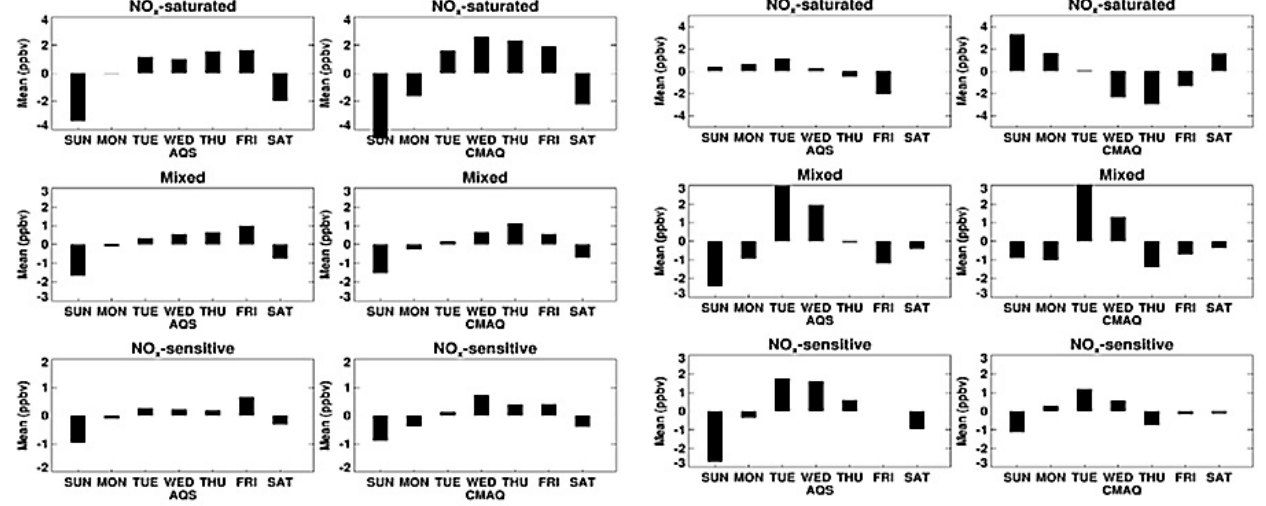
Fig. 8. Weekly anomalies of AQS-observed and CMAQ-simulated ground-level NO x at EPA AQS NO x stations (left two columns) and O 3 concentrations at EPA AQS O 3 stations (right two columns) over CMAQ-derived chemical regimes (i.e., NO x -saturated, mixed, and NO x - sensitive regimes, see the right panel of Fig. 3) for August 2009. Only daytime (01:00–05:00p.m., local time) NO x and O 3 concentrations are used; some data are filtered out from 17–19 August 2009, when Tropical Storm Ana strongly affected air quality over the eastern